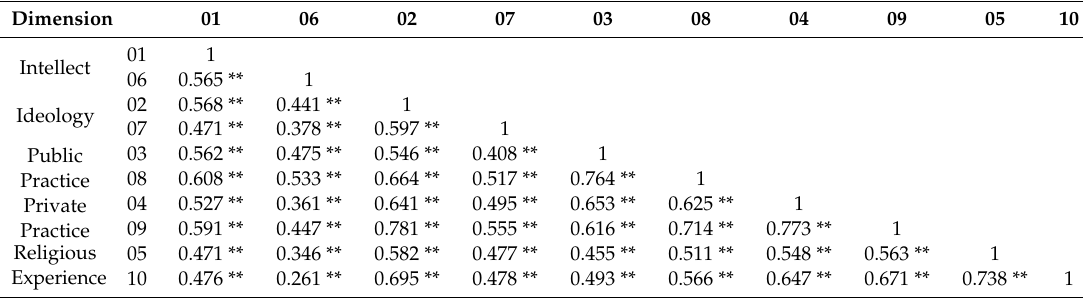
Table 5. Correlations among ten CRS